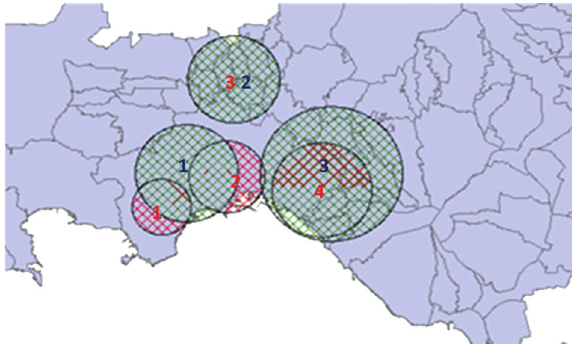
Figure 8: Edema of bilateral Reinke disease—years 2011 and 2012: display of the two hotspots’ series.